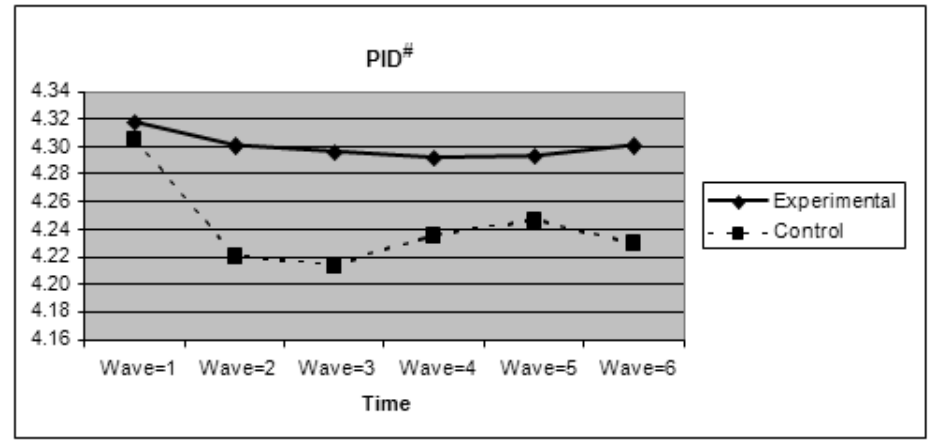
FIGURE 3. Growth trajectories of the experimental participants and control participants using PID # as an outcome indicator. # Positive identity second-order factor.